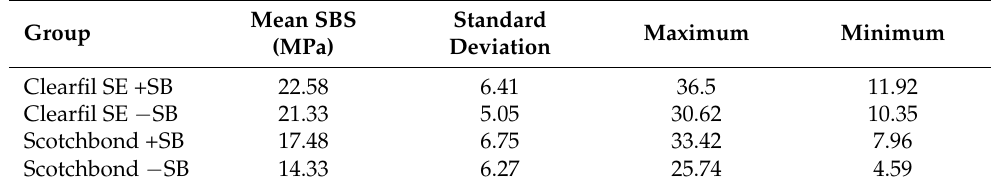
Table 4. Results of the shear bond strength (MPa) test.